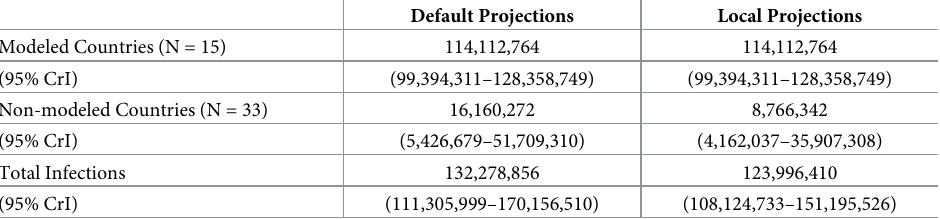
Table 1. Total infections in modeled and projected countries and territories under two different projection meth- ods. Default method used parameter estimates from all 15 modeled countries, while local method used only parameter estimates from neighboring countries and territories or those with similar characteristics.